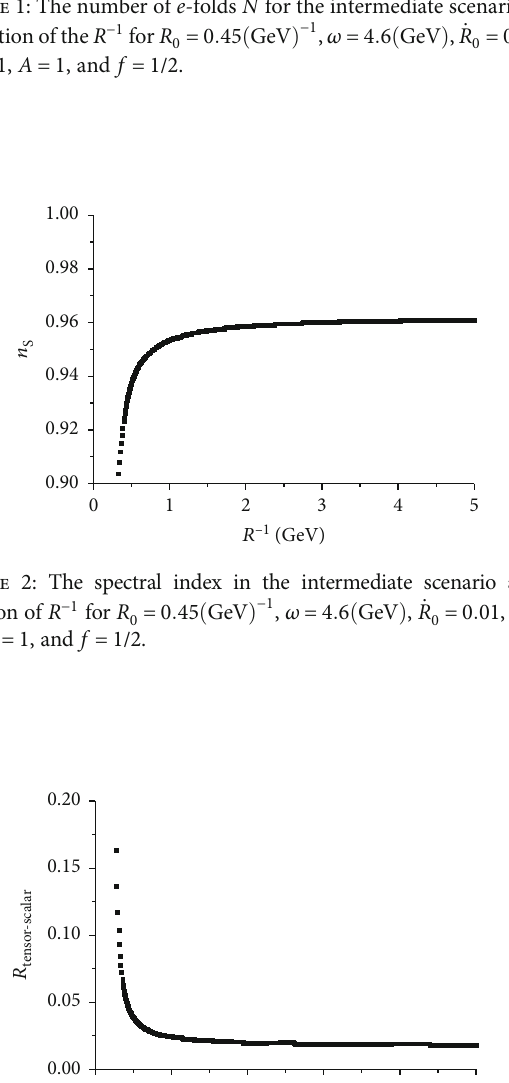
Figure 3: The tensor-scalar ratio in the intermediate scenario as a function of R − 1 for R 0 : 1 , A = 1 , and f = 1/2 .